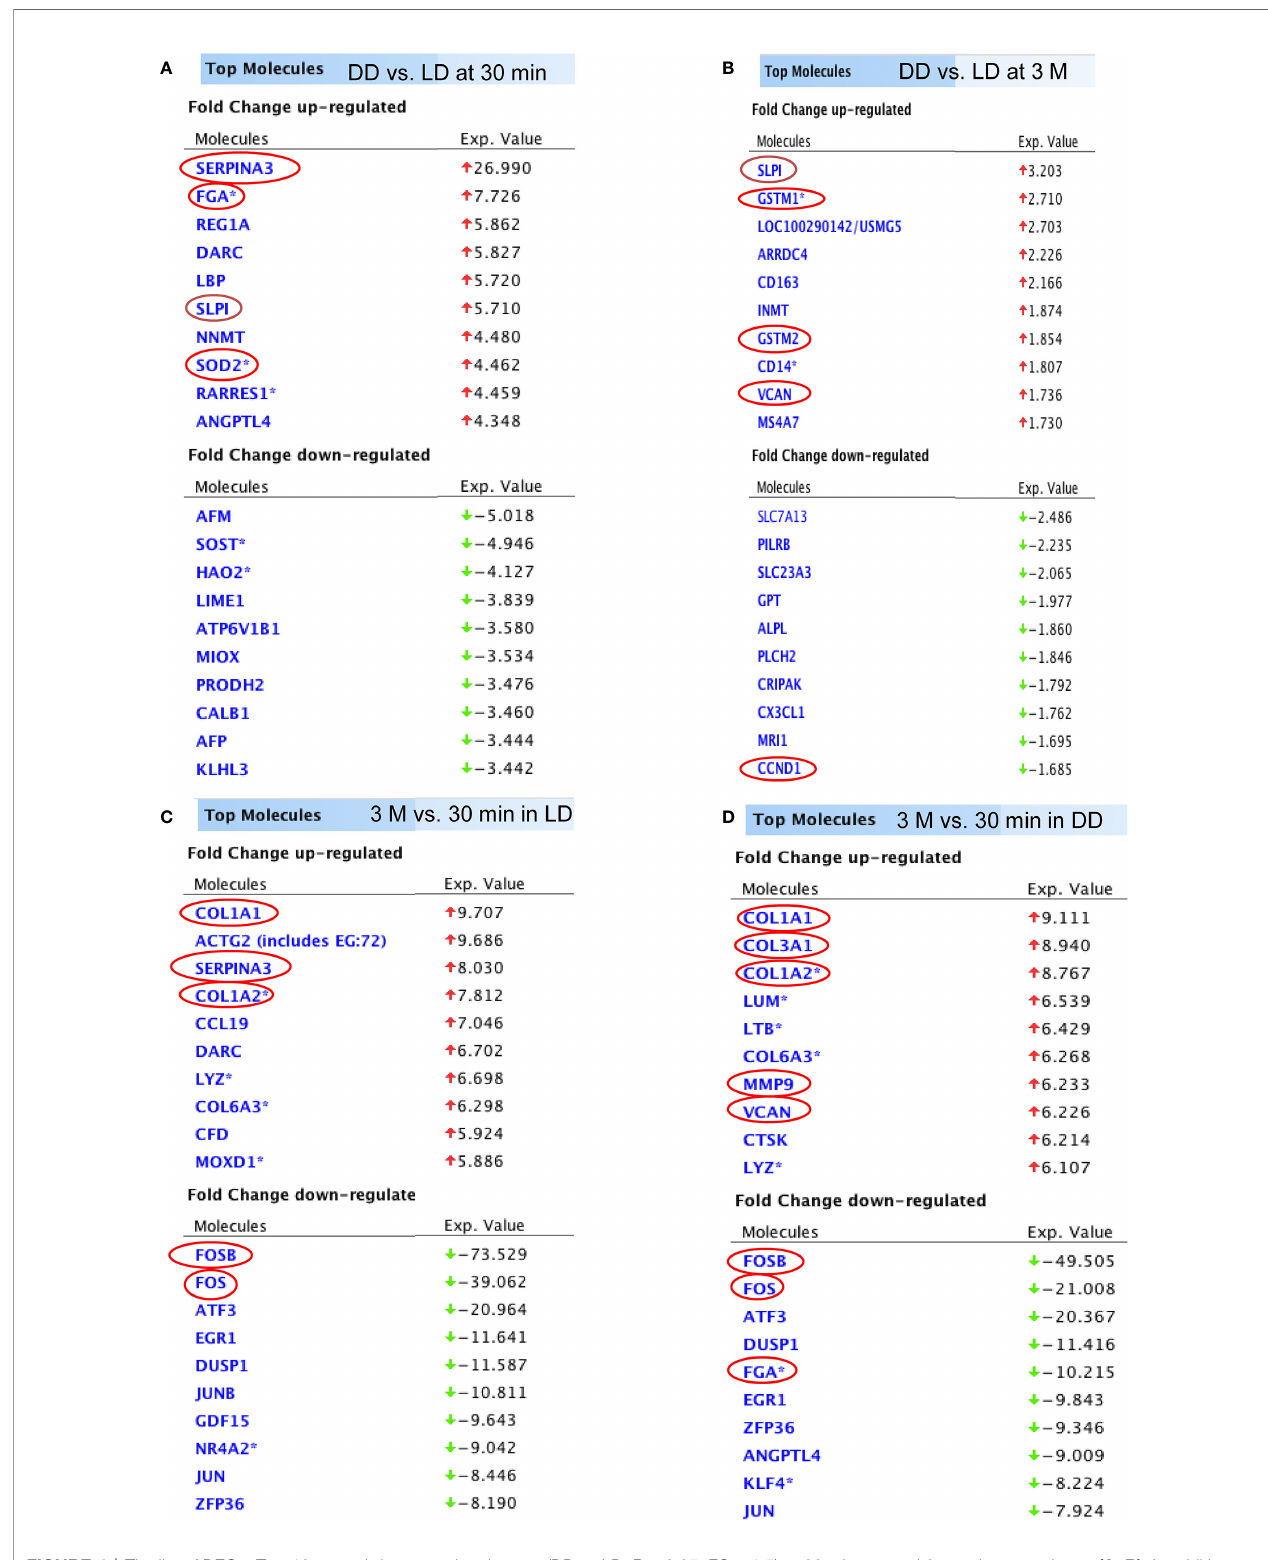
FIGURE 4 | The list of DEGs. Top 10 up and down-regulated genes (DD vs LD, P < 0.05, FC > 1.5) at 30 minutes and 3 months were shown (A, B) . In addition, top 10 up and down-regulated genes (3 months vs 30 minutes, P < 0.05 and FC > 1.5) in LD and DD (C, D) respectively were also